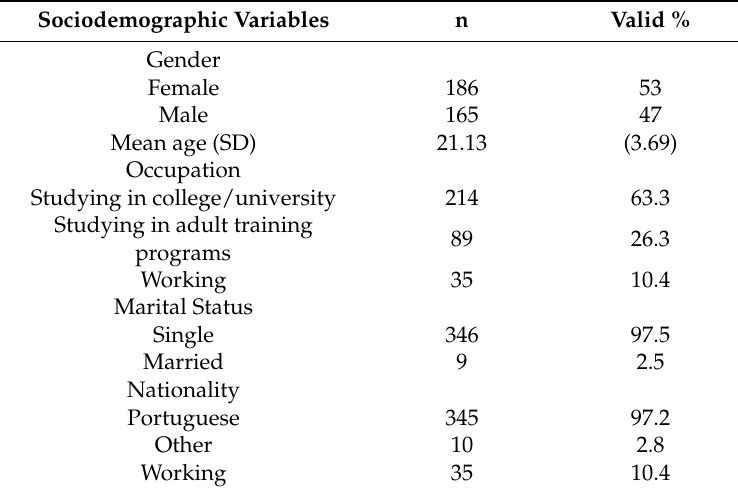
Table 2. Sociodemographic characteristics of the